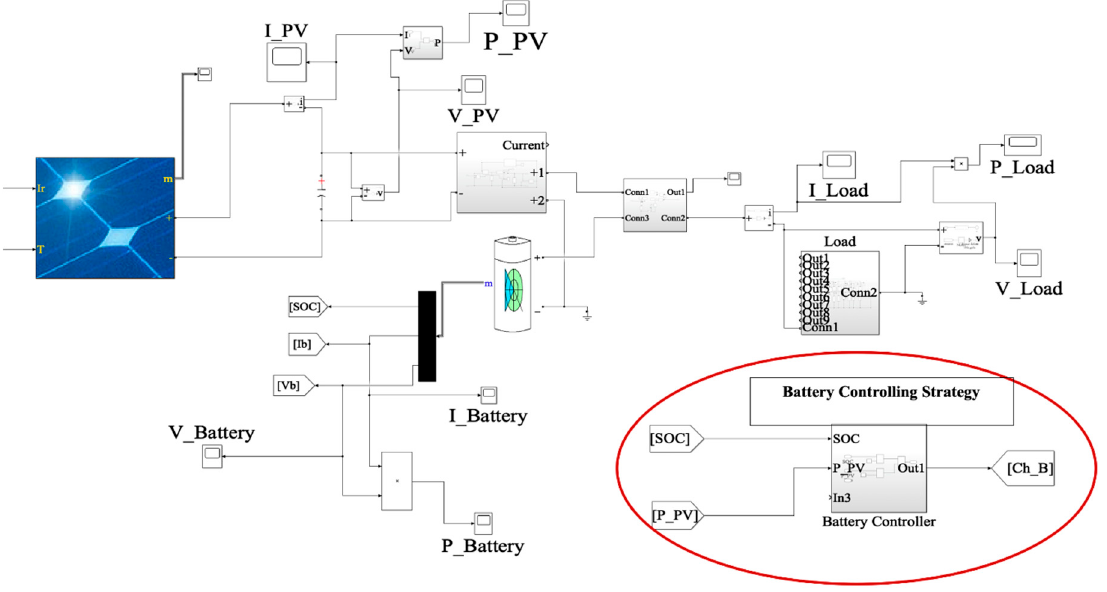
Figure 11. DC microgrid design using MATLAB/Simulink.